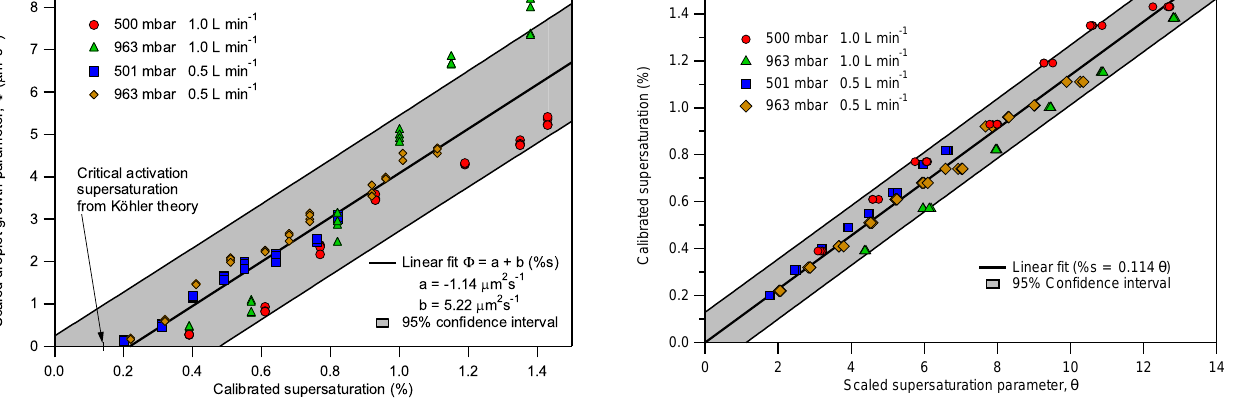
Fig. A2. Calibrated supersaturation versus scaled supersaturation parameter ( θ ) for measured 100nm ammonium sulfate